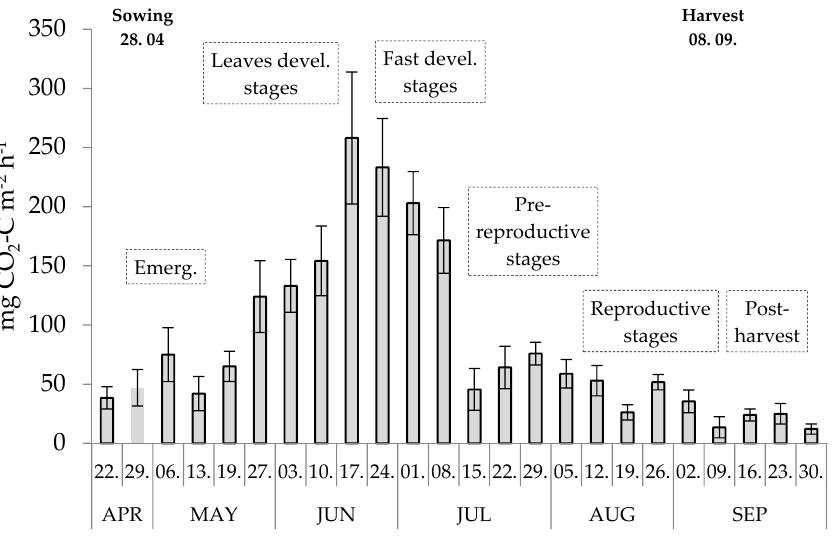
Figure 4. CO 2 ‐ C emissions from the soil. Figure 4. CO 2 -C emissions from the